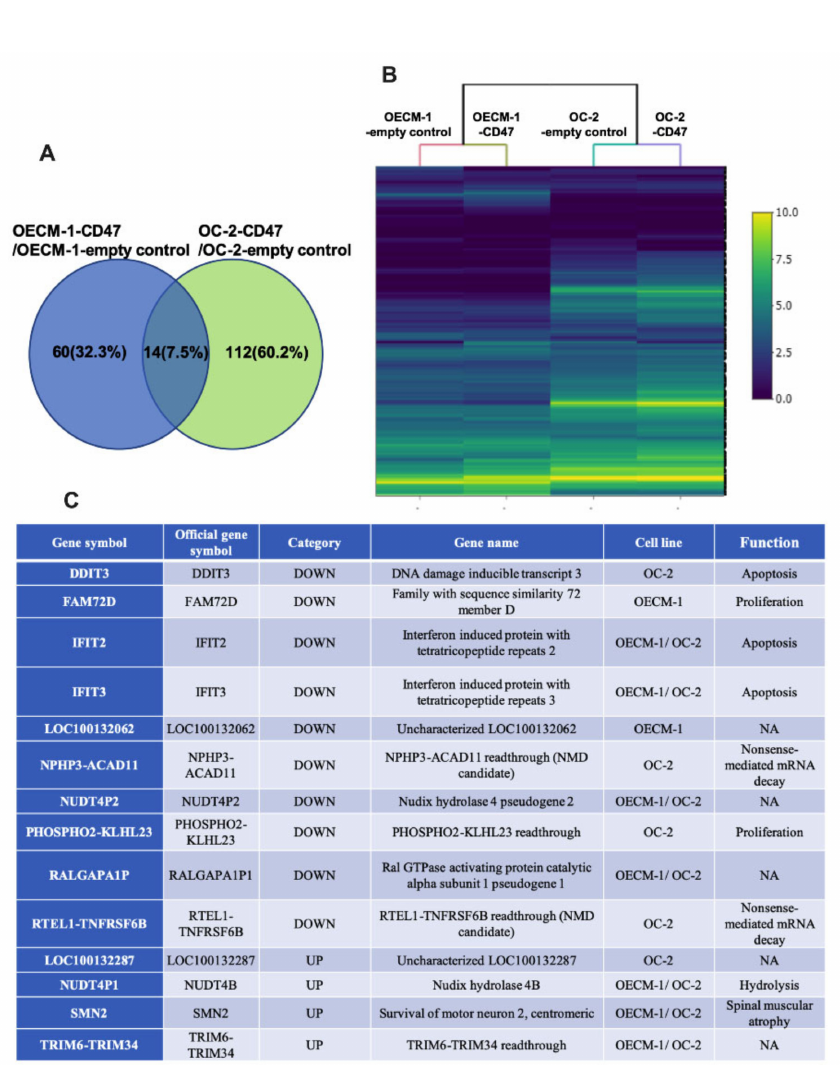
Figure 3. The function of differentially expressed genes in CD47-overexpressing oral cancer cells. ( A ) The number of DEGs in each comparison was determined by RSEM and EBSeq (PPEE ≤ 0.05). Fourteen genes were found to be involved in molecular functions, biological processes, and cellular components. ( B ) Heatmap demonstrating the expression profiles of union sets. The color bar on the right side indicates the log2 fold changes. ( C ) The list presents the 14 associated genes, including the DEGs in OECM-1 and OC-2 cells and their functions in biological processes. NMD: nonsense- mediated mRNA decay; Readthrough: continuous transcription; NA: not